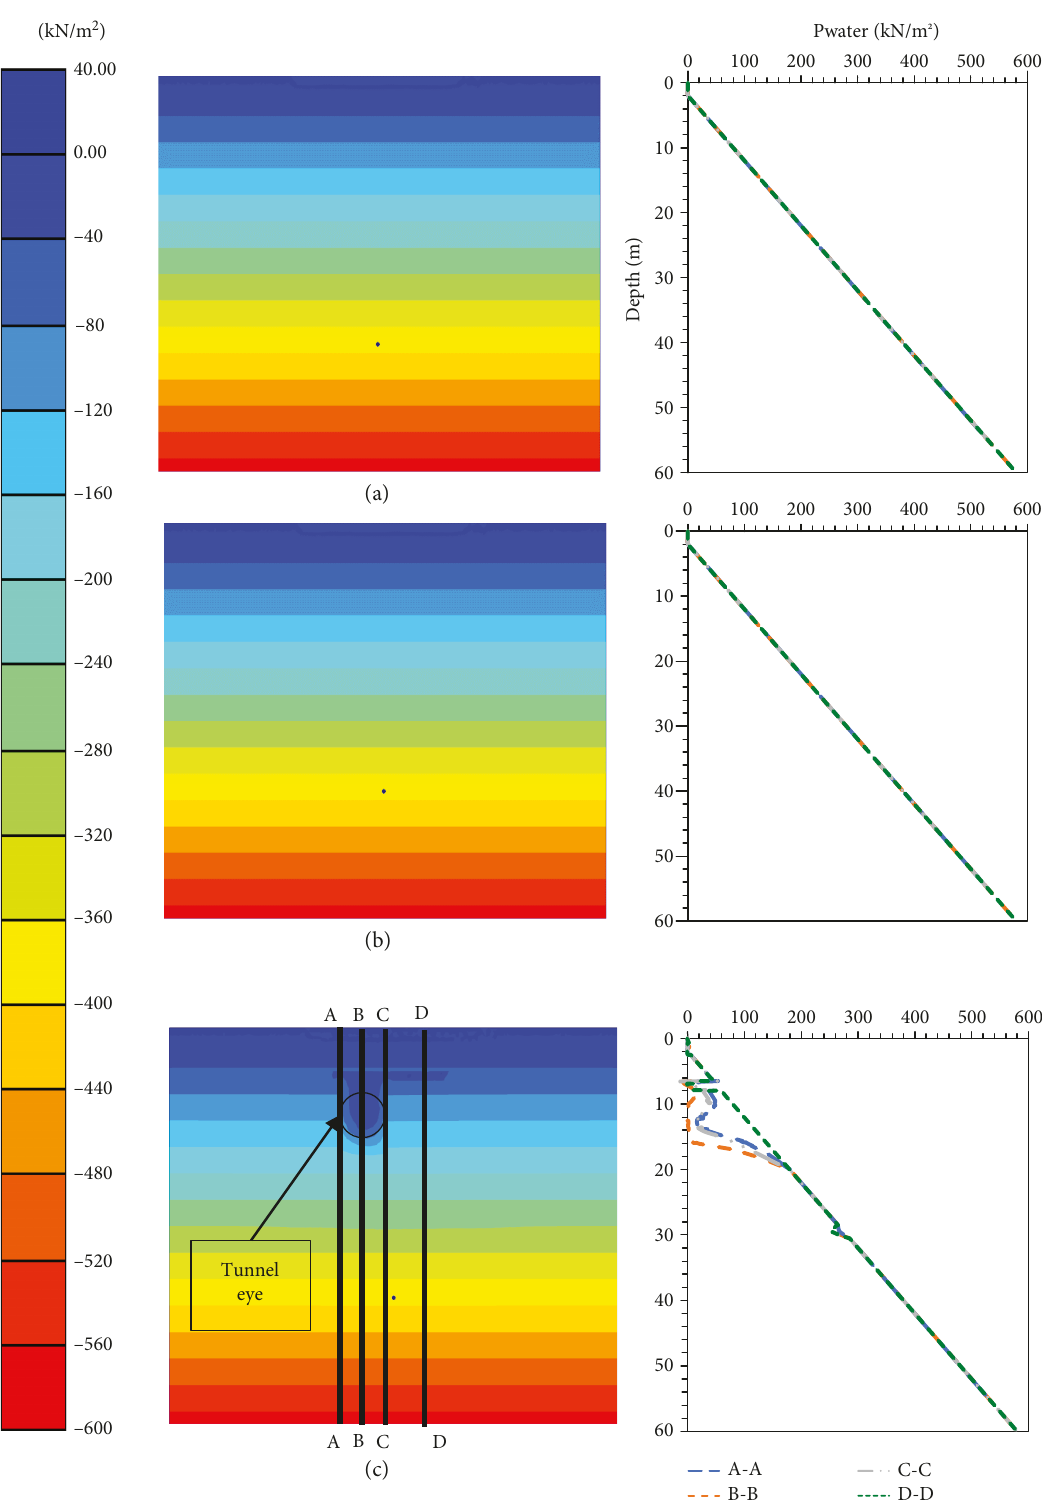
Figure 7: Change of pore pressure distribution at various depths and locations at di ff erent phases of launching of a shield in transverse direction. (a) Initial phase. (b) Main excavation. (c) Launching of the shield. Note: A-A: left side of tunnel eye; B-B: center of tunnel; C-C: right side of tunnel eye; and D-D: 5 m away from the right side corner. “ - “ in pore pressure distribution contour is positive pore pressure and “ Pwater ” means pore